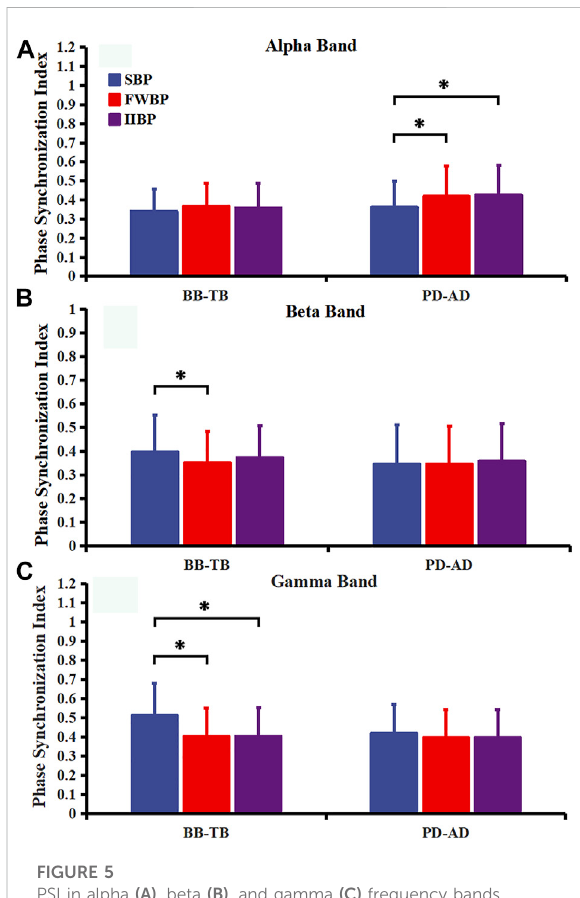
FIGURE 5 PSI in alpha (A) , beta (B) , and gamma (C) frequency bands between EMGs of antagonist muscle pairs (BB-TB and PD-AD) for three different bench press conditions. Results are expressed as mean ± SD. Signi fi cant differences are indicated by asterisks ( p <